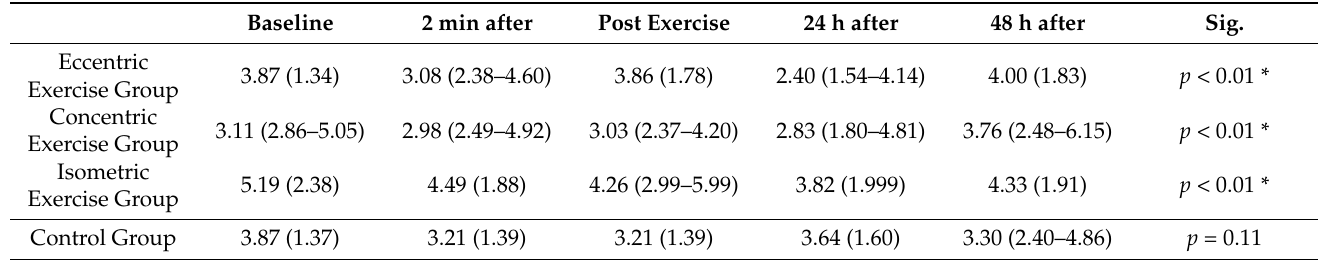
Table 3. Change in pressure pain threshold (kg/cm 2 ) over time within each group.